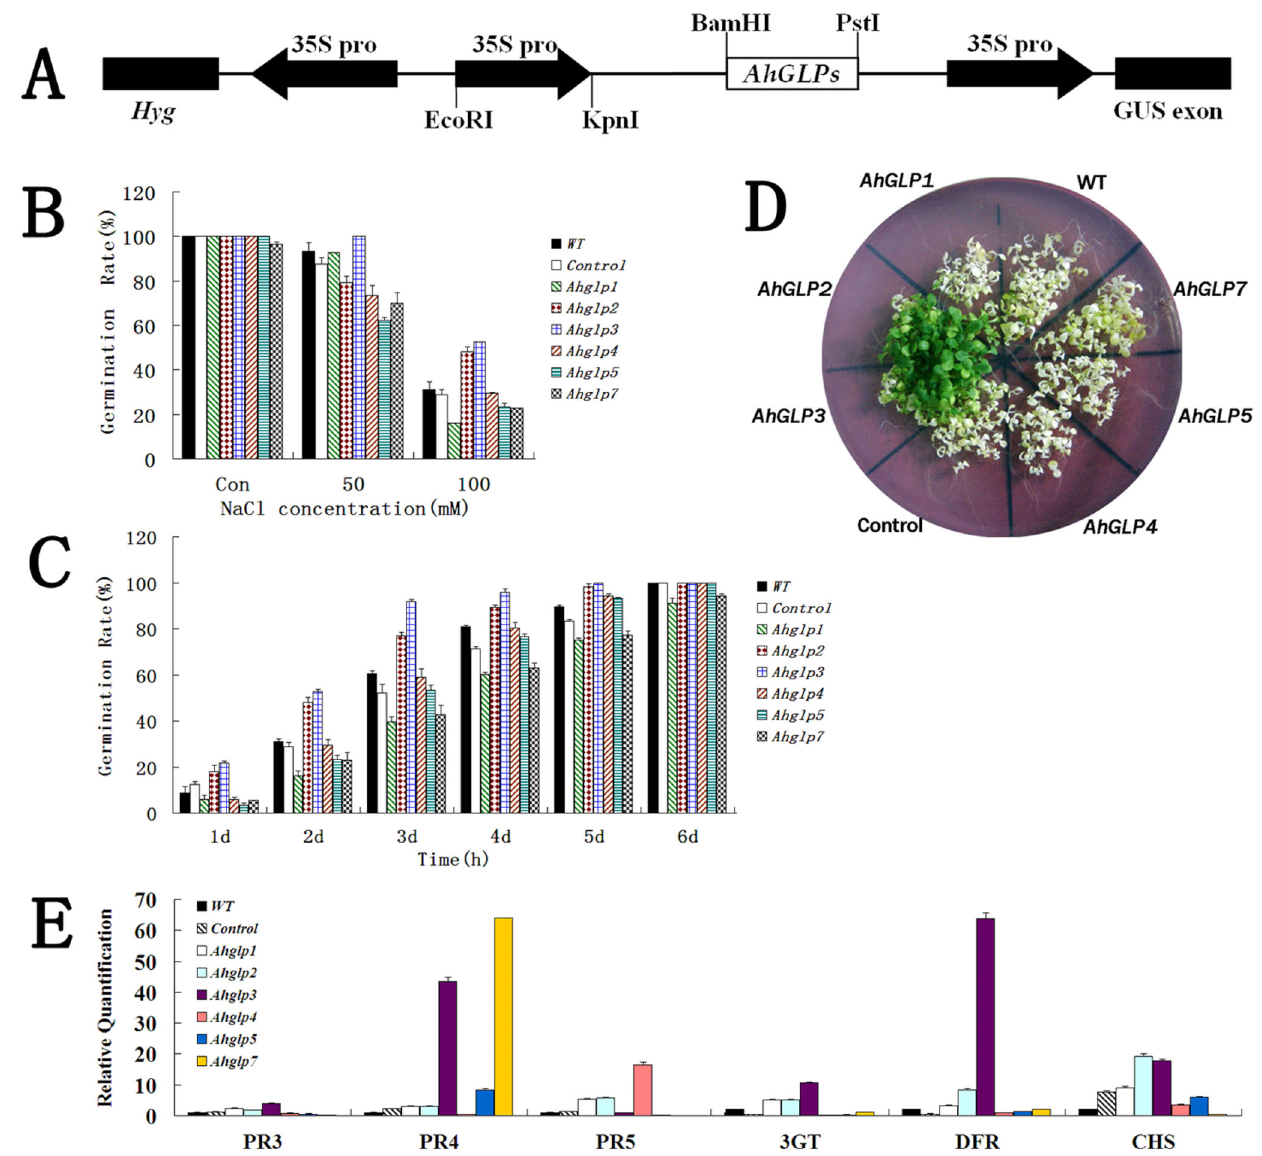
Figure 6. Overexpression of AhGLP s and salt tolerance analysis in transgenic Arabidopsisthaliana . WT: wild type; control: The modified pCAMBIA1301 inserted with 35S only was used as negative control. (A): Diagrams of the constructs (the pCAMBIA1301-35S- AhGLP1 , 2 , 3 , 4 , 5 and 7 ) used for Agrobacterium tumefaciens -mediated transformation of Arabidopsis . (B): Effects of different NaCl content (0, 50 and 100 mM) on the germination of transgenic Arabidopsis seeds for 5 days after germination; (C): Comparison of germination rates and percentages of seedlings with green cotyledons between transgenic lines and wild-type plants under 100 mM NaCl stress. (D): The seeding cultivated on 1/2 MS agar plate containing 50 mM NaCl for 15 days. (E): Transcript analysis of AhGLPs -activated defense related genes (DFR, CHS, 3GT, and AtPR3, 4 and 5) in transgenic Arabidopsis plants.